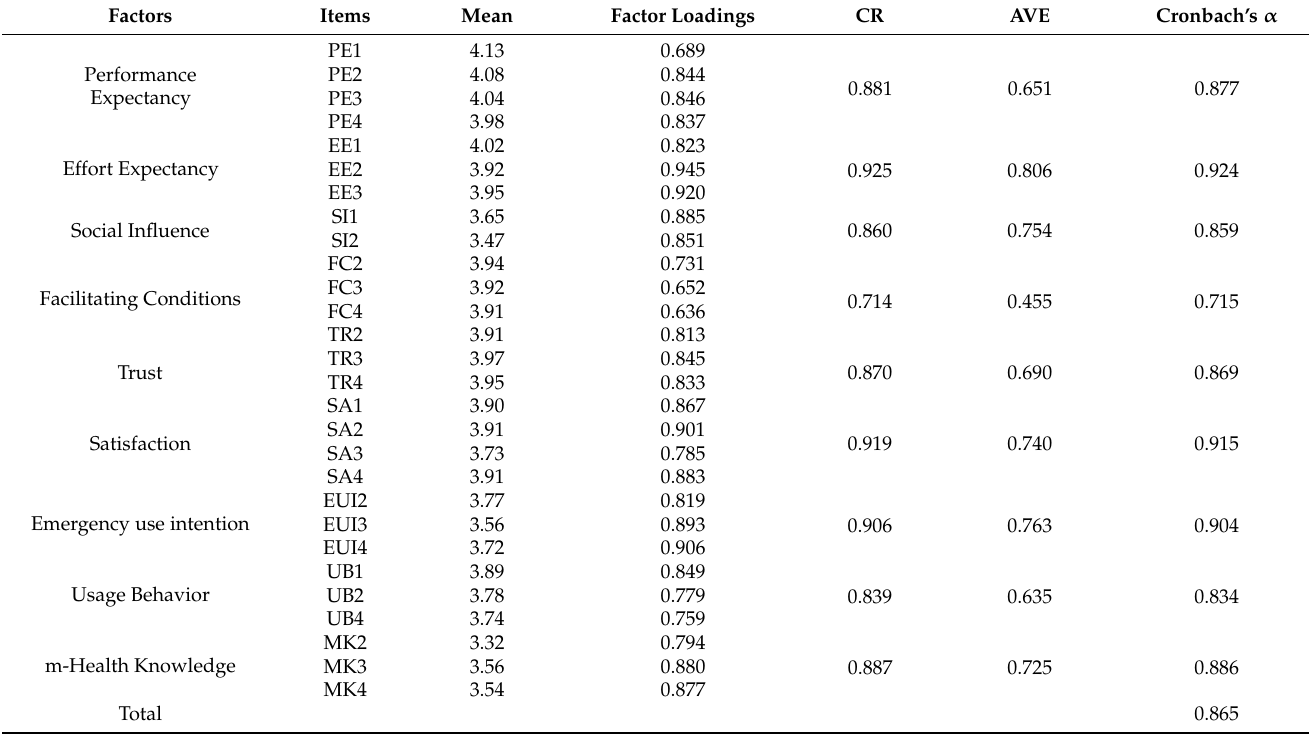
Table 3. Standard item loadings, Cronbach’s α , Composite Reliability, and Average Variance